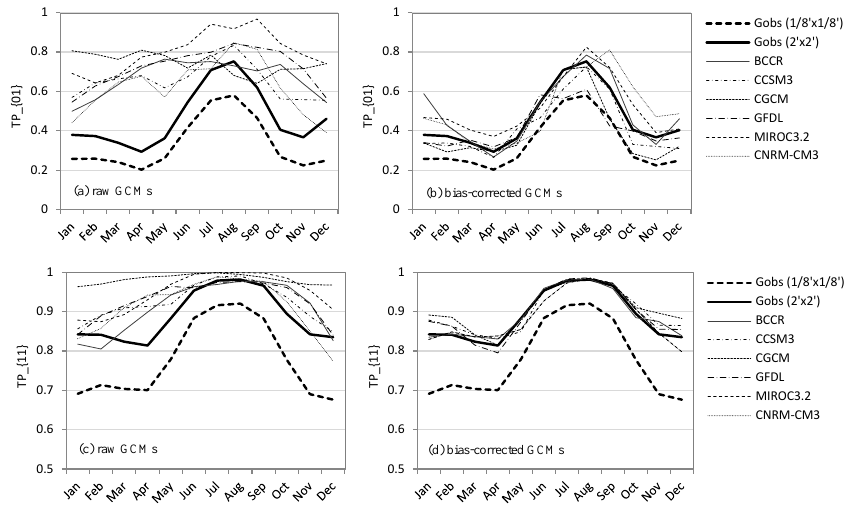
Fig. 11. Comparison of monthly first-order dry to wet (TP_{01}, upper raw) and wet to wet (TP_{11}, bottom row) transition probabilities for raw GCM data (first column) and bias-corrected GCM results (second column). Averaged transition probabilities for all grids over the study area (i.e., the state of Florida) were plotted for each GCM. Transition probabilities of the gridded observation were calculated both at 1/8 ◦ resolution (original resolution of Gobs) and 2 ◦ (aggregated up to approximate average grid scale of GCMs, see Table 1).